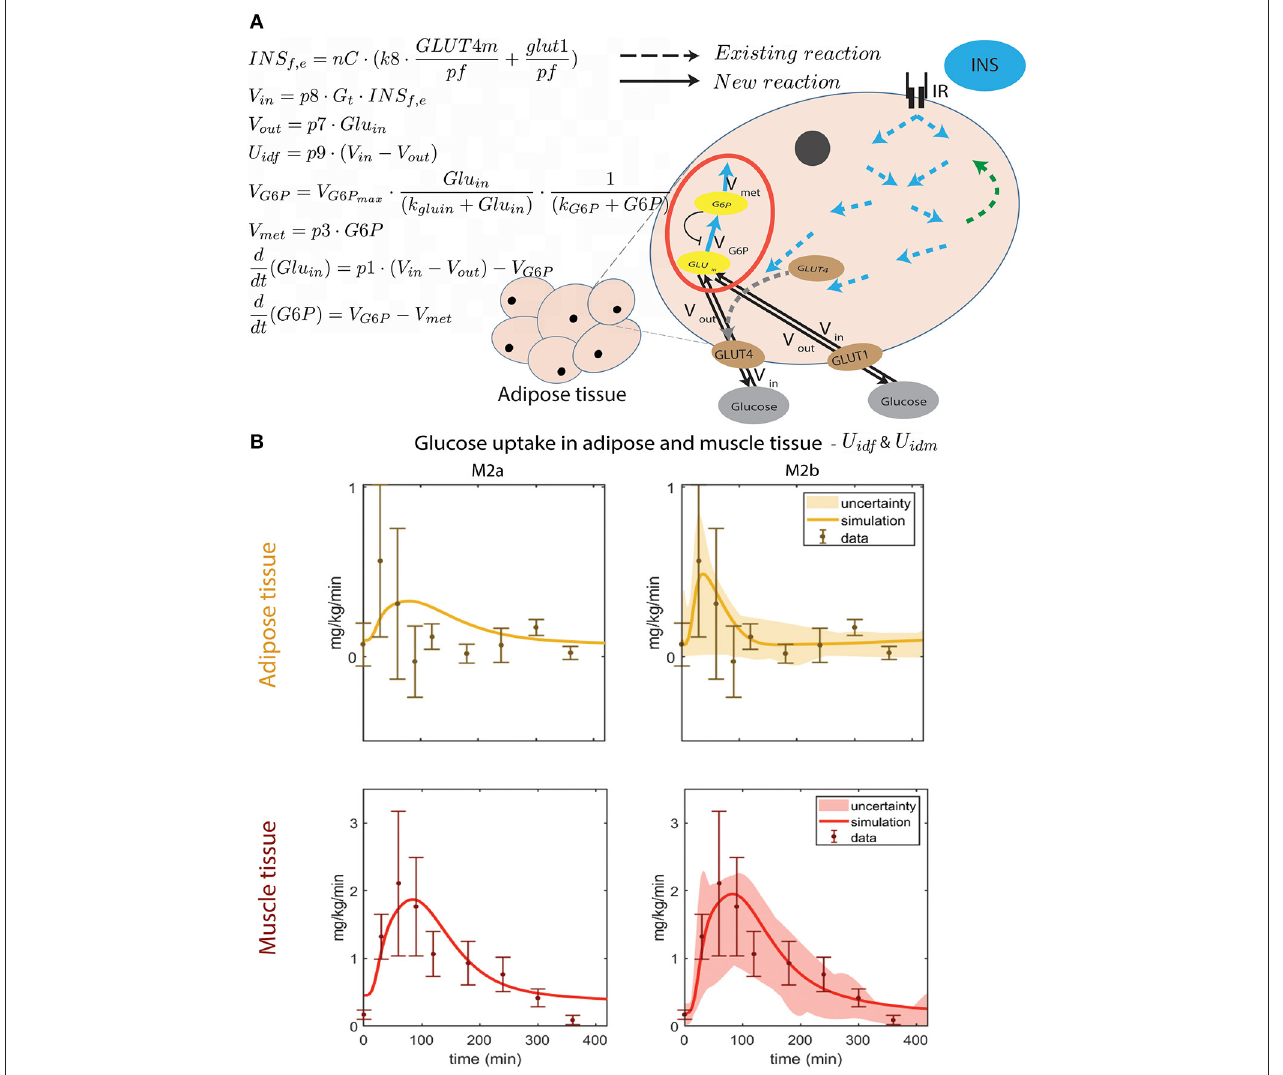
FIGURE 3 | Improved dynamic behavior of adipose tissue glucose uptake by improved intracellular module. (A) Illustration of the new intracellular adipose tissue module and ODE equations added to M2b. The flow of glucose in to the cell, V in , is dependent on the amount of glucose in interstitium ( G t ) and inside the cell ( Glu in ), and the amount of GLUT 4 m and GLUT 1 membrane glucose transporters through INS f , e . The out flow, V out , is only dependent on Glu in , which in turn depends on, V in , V out , and the phosphorylation of glucose into G6P ( V G 6 P ). The rate of phosphorylation to G 6 P is only dependent on V G 6 P and the usage of G 6 P in metabolism ( V met ). These equations are detailed in Methods, Equations (11–18). In M2b, the parameters introduced in these equations are optimized together with V m , V mx , K m , V l , V l , K l , U ii , part m , part f , and part l . For all optimized parameters in M2b with a description and their values, see Supplementary Table 4 . The equations of the intracellular module that already existed in the original multi-level model (i.e., those of M0, represented by dotted lines for reactions) are kept unchanged in all models presented herein. They are represented by the dotted arrows and describe the insulin induced intracellular signaling, resulting in glucose uptake in the cell. Specifically, they represent the phosphorlyation of intracellular proteins. For example, the two blue arrows pointing out from IR (the insulin receptor) represent the IR-induced phosphorylation of IRS1. For details on this part of the intracellular adipocyte module, see Equations (23–50) in supplementary Figure 1 , and (Nyman et al., 2011). (B) Timing comparison between uptake seen in data and the two models: M2a without phosphorylation, and M2b with glucose phosphorylation. In M2b, the peak comes earlier and the quantity of glucose taken up is closer to data than in